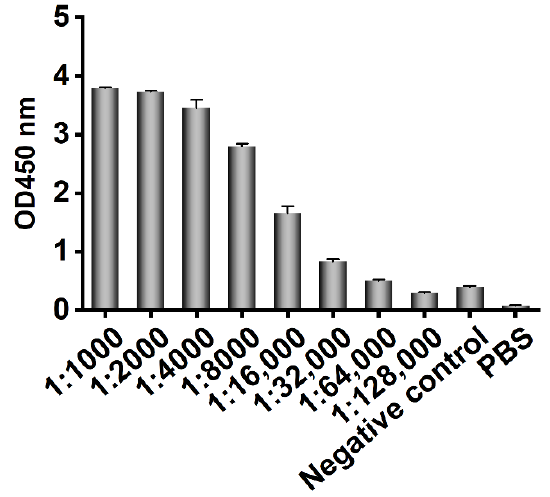
Figure 1. The serum antibody titer of Bactrian camel after immunization was determined by ELISA. CD20 extracellular polypeptide was coated in microplates. Basic serum isolated before immunization was used as negative control, PBS was used as blank control, rabbit anti-camel antibody labeled with HRP was used as a secondary antibody with the working concentration of 1:10,000, and TMB was used for color development. The plate was read at OD450 nm in a microplate reader.